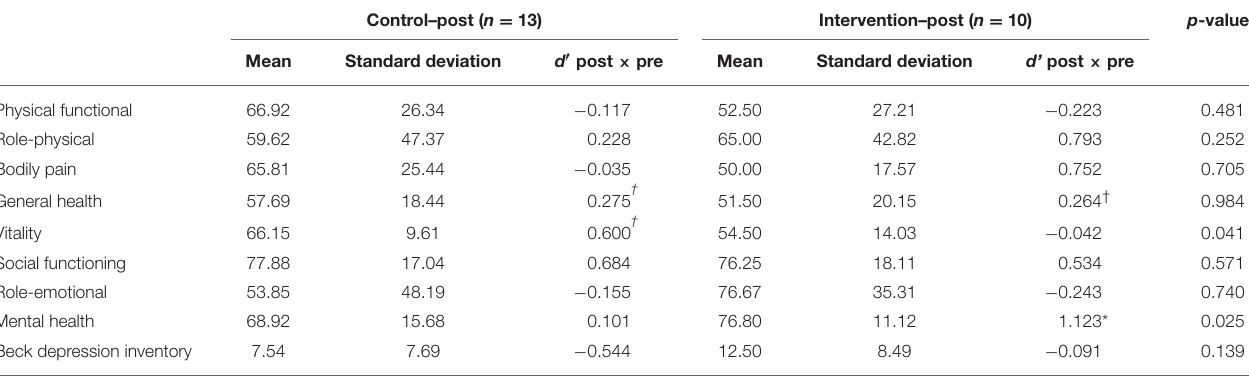
TABLE 2 | Effect of the treatment on the intervention group compared to the control group (no treatment) in relation to the quality of life questionnaire SF-36 and the Beck Depression Inventory ( n = 23).